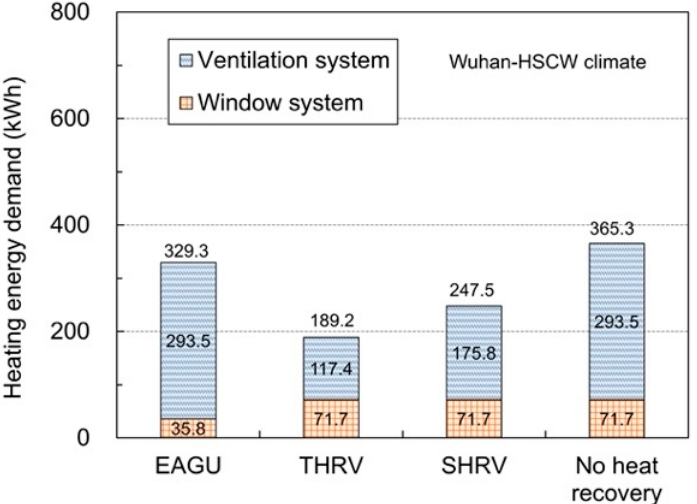
Figure 10. Seasonal total energy demand of the four cases in the heating season.